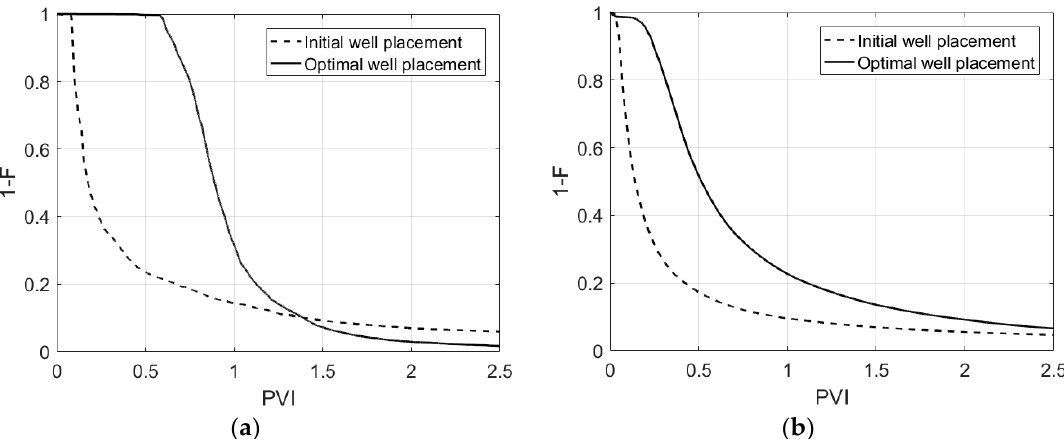
Figure 15. The fractional recovery proxy plots illustrating the early time behavior of the initial and optimal P&T remediation designs for the heterogeneous ( a ) two- and ( b ) three-dimensional test problems.